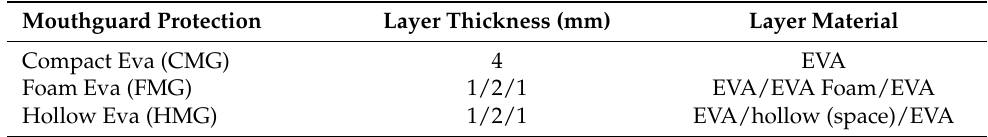
Table 1. Description of the three mouthguard protections, namely, thickness and